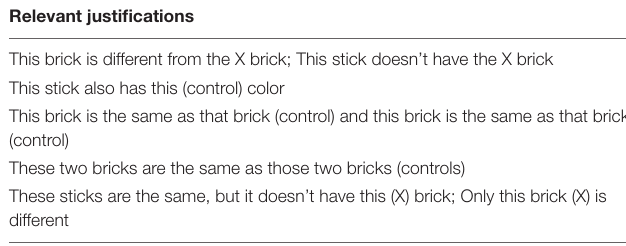
TABLE 2 | Examples of children’s justifications for their test